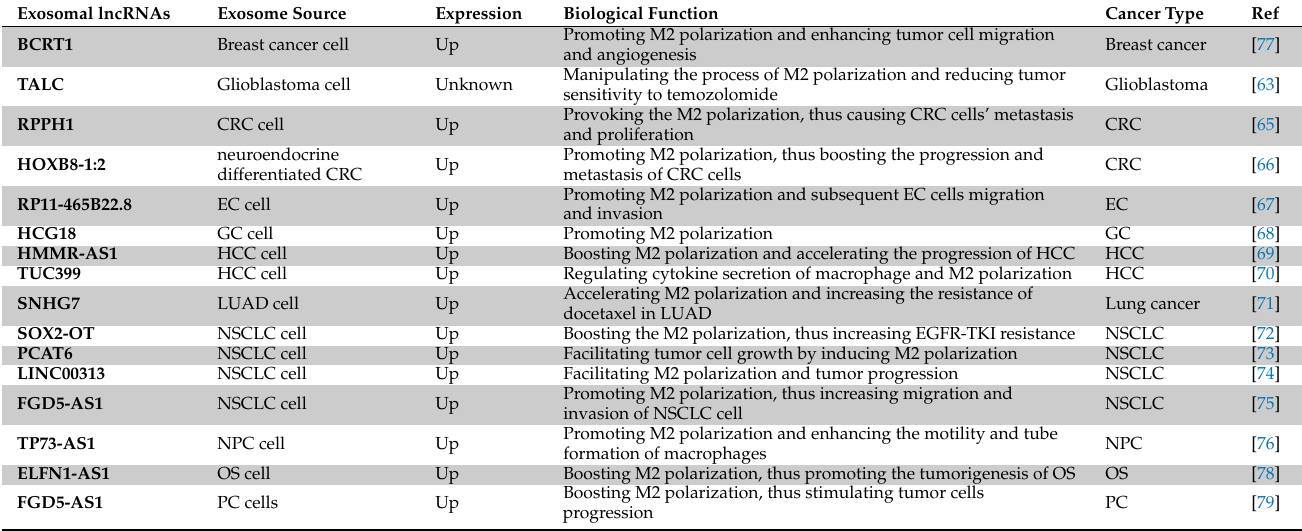
Table 1. Summary of immunoregulation role of exosomal lncRNAs in